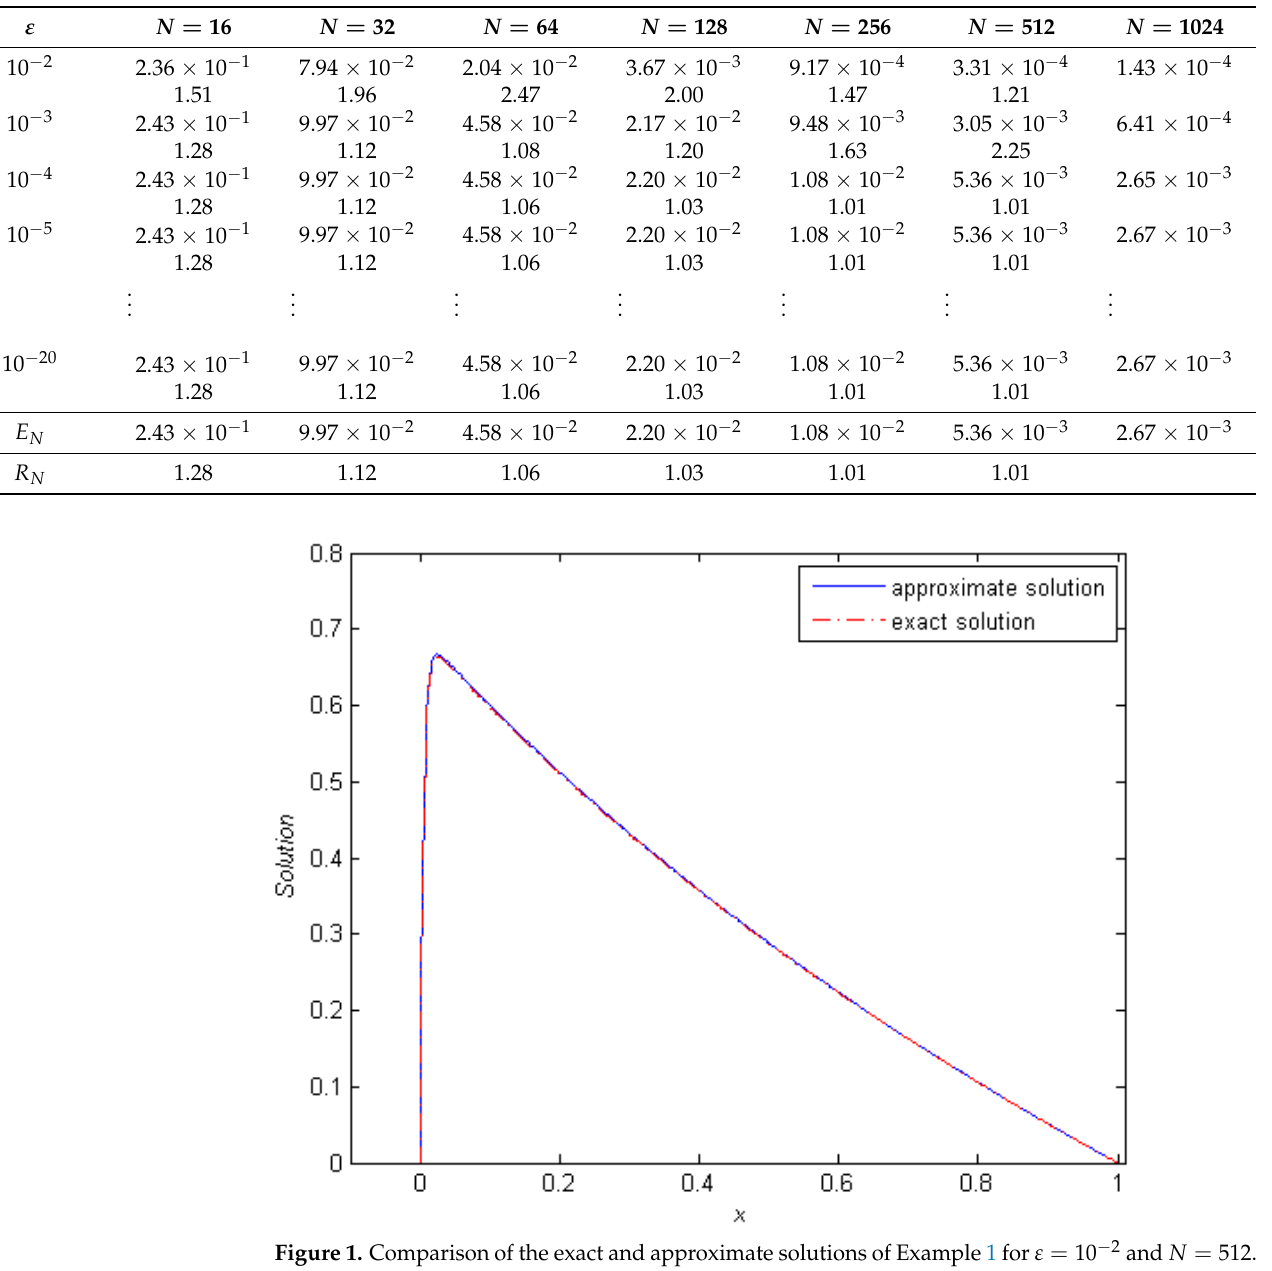
Table 4. Results for Example 4: maximum errors and convergence rates for FOFDM.